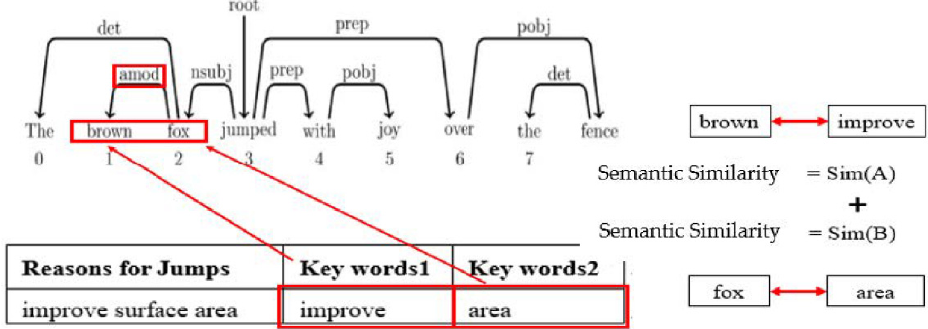
Figure 6. Illustration of the similarity calculation between corresponding text keywords and dic-